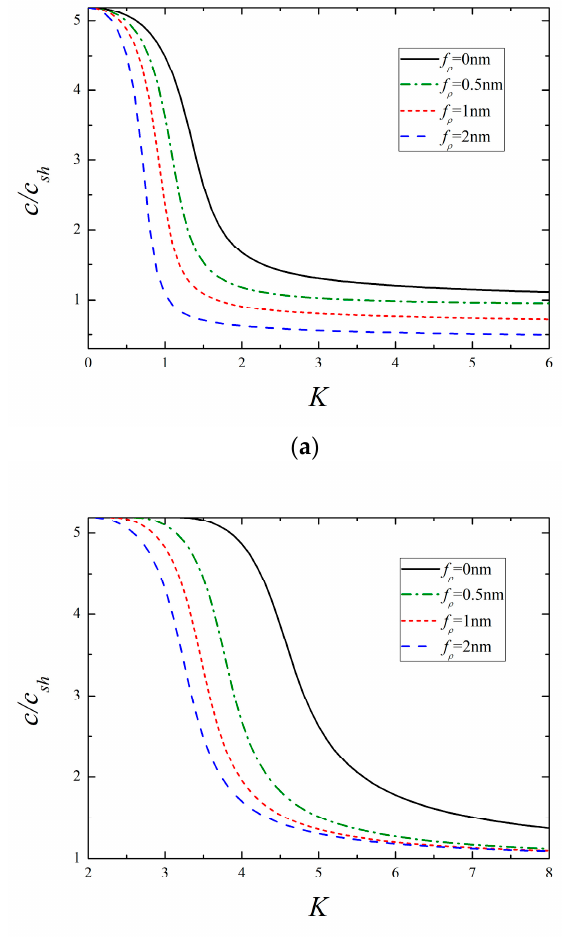
Figure 7. The lowest two modes for different surface density ( f c = f e = 0.5 nm, f κ = 1 nm). ( a ) The 1st mode and ( b ) the 2nd mode.